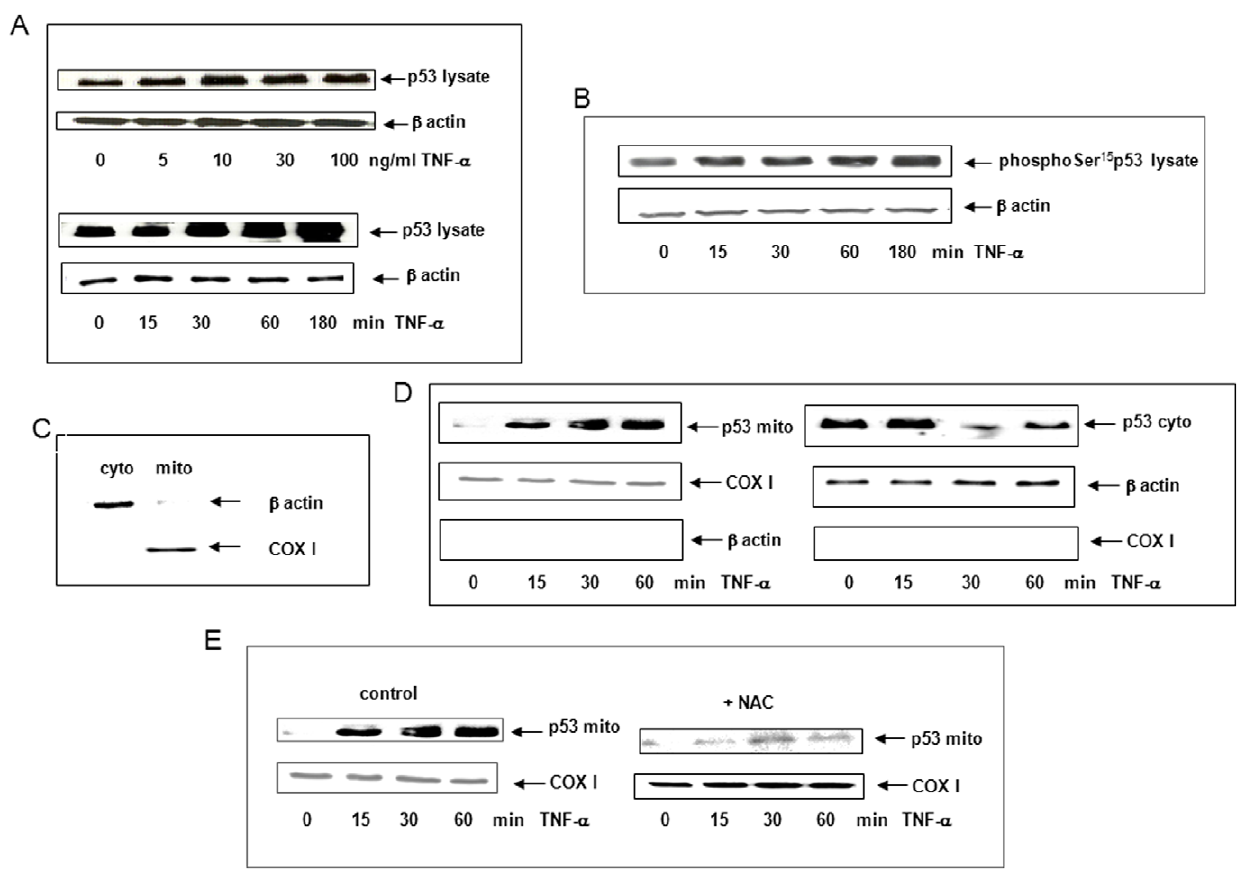
Figure 4. TNF- a induced p53 translocation to mitochondria. (A) Accumulation of p53 was investigated by Western Blot using p53 antibody in lysate from cells treated for 1 h with 5–100 ng/ml TNF- a or with 30 ng/ml TNF- a for 0 to 180 min. b -actin served as a loading control (B) Accumulation of phosphoSer 15 p53 was investigated by Western Blot in lysate from cells treated for 0–180 min with 30 ng/ml TNF- a . b -actin served as a loading control. (C) Mitochondrial (mito) and cytoplasmic fractions (cyto) were isolated as described in Material and Methods and their purities checked by Western Blot using b -actin antibody (cytoplasm) and COXI (mitochondria). (D) The translocation of p53 to mitochondria was investigated by Western Blot using p53 antibody on mitochondrial (mito) or cytoplasmic (cyto) fractions isolated from cells treated or not for 0 to 60 min with 30 ng/ml TNF- a . COXI and b -actin served as loading controls. (E) Cells were pretreated or not (control) for 1 h with 5 mM NAC before exposure to TNF- a . Western Blots were performed using p53 antibody. COXI was used as a loading